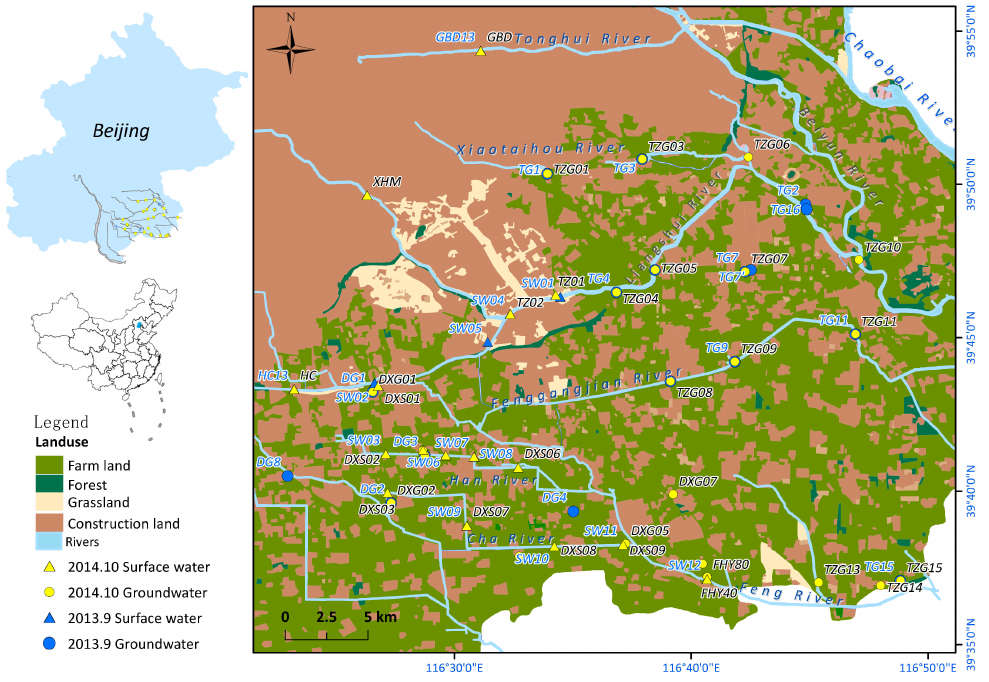
Figure 1. Location of the study area and sampling